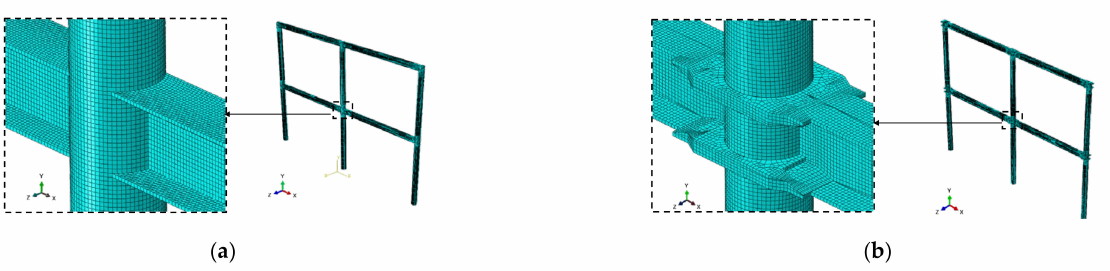
Figure 2. Detailed models of circular-tube-column frames with different joints: ( a ) Model A c ; ( b ) Model B c .